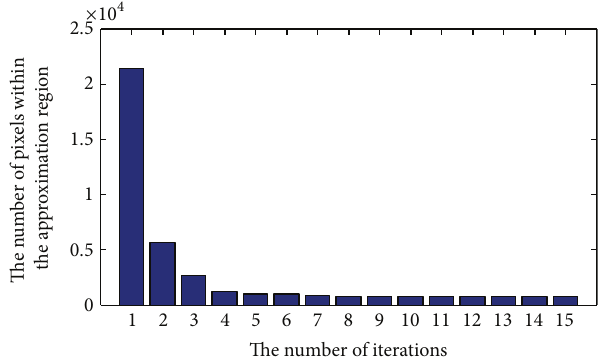
Figure 4: The number of pixels within approximation regions near the contour boundaries changes over